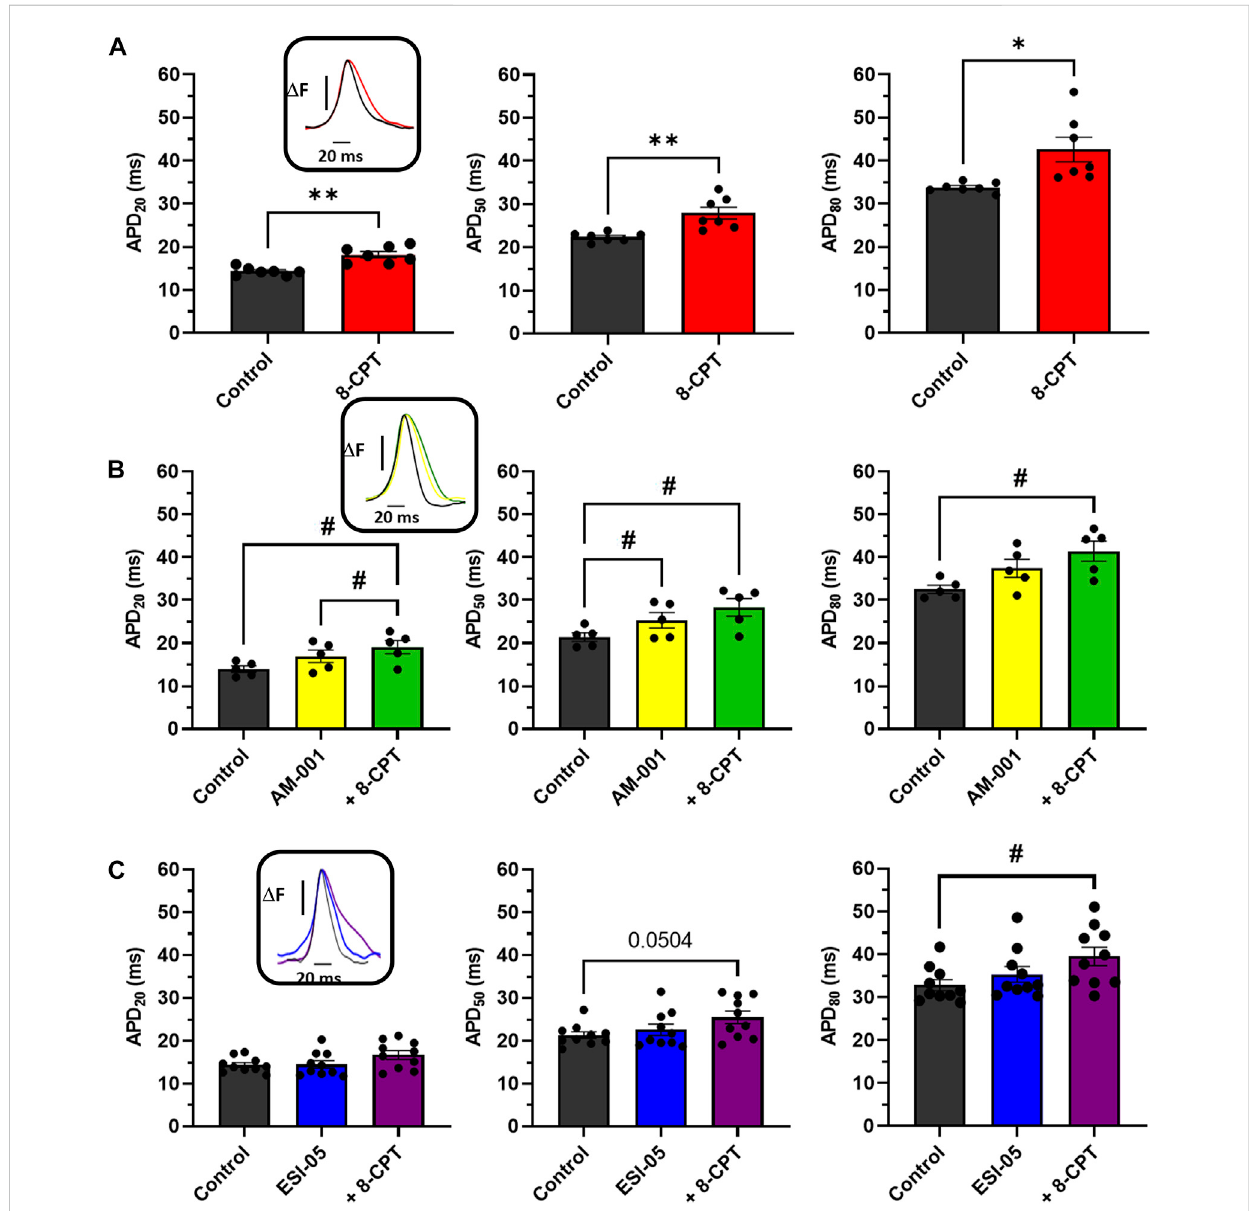
FIGURE 4 Impact of various EPAC isoforms on LA and RA APD. (A) Activation of EPAC1&2 by 8-CPT increases APD20, 50, 80. ( N = 7) (B) Activation of EPAC2 pathway by inhibition of EPAC1 following by the activation of EPAC2 using AM-001 and 8-CPT increases APD20, 50, 80. ( N = 5) (C) Activation of EPAC1 pathway by inhibition of EPAC2 following by the activation of EPAC1 using ESI-05 and 8-CPT tends to increase APD20, 50 and 8-CPT increases APD80. ( N = 10). Statistical differences were determined by paired t-tests [ (A) , * p < 0.05; ** p < 0.01], and by ANOVA with Tukey post hoc test and Kruskal Wallis with Dunn post hoc test [ (B,C) , # p <